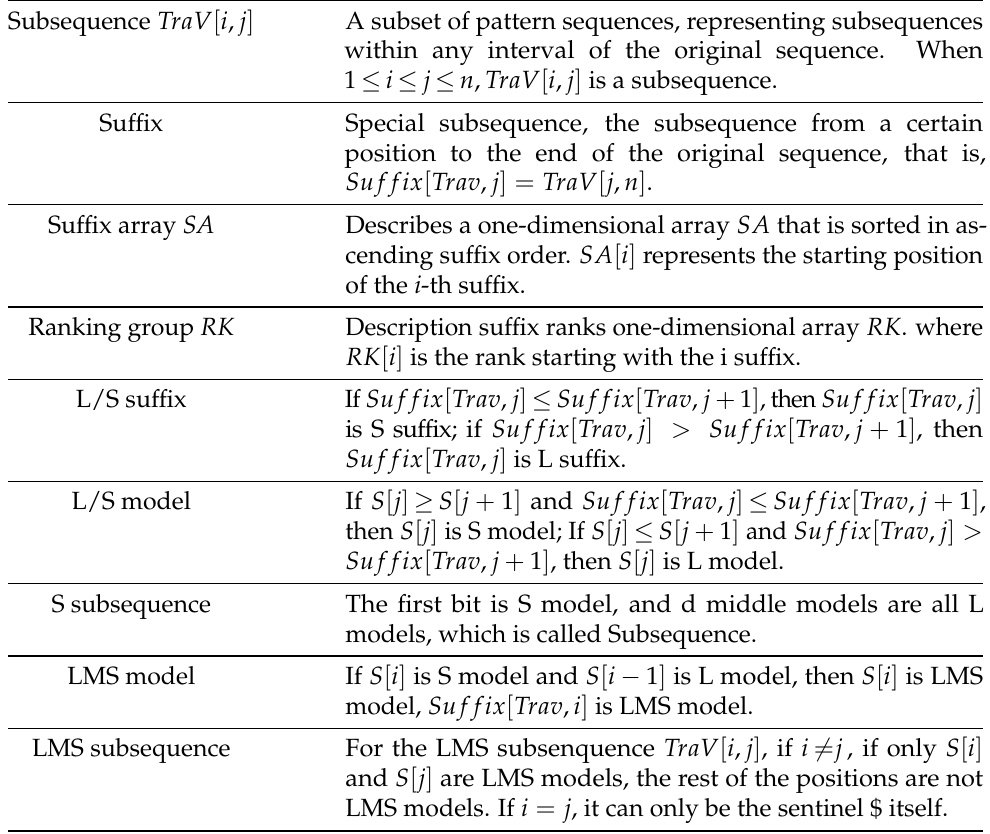
Table 1. Concepts used by the suffix array generation